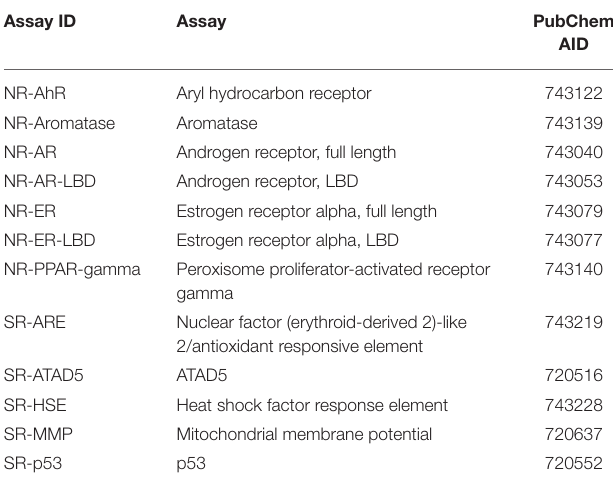
TABLE 1 | Tox21 assays used in